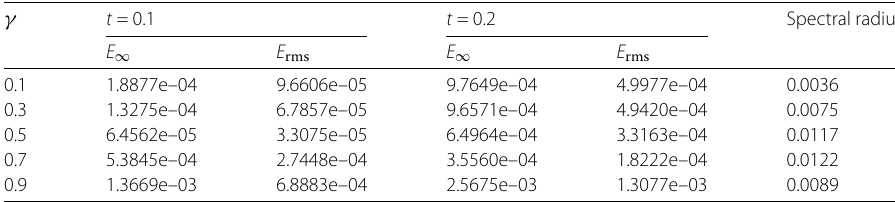
Table 1 Error norms of Example 5.1 at J = 4, τ = 0.01, θ = 1